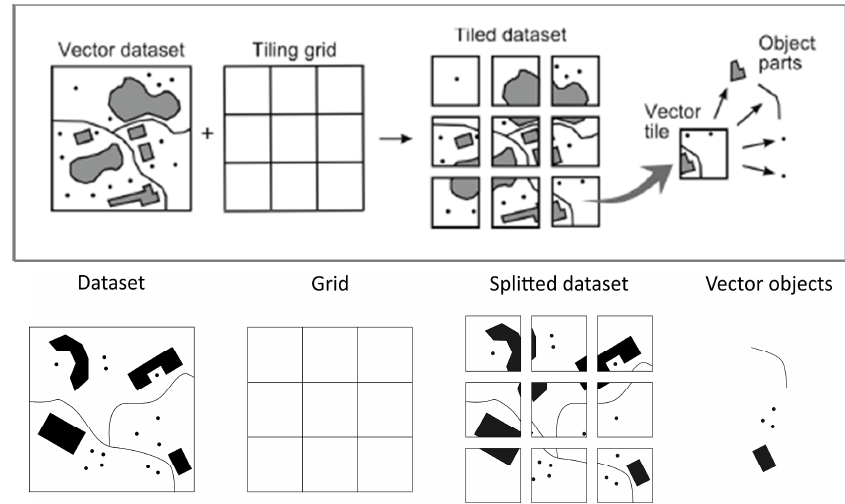
Figure 2. The process of generating vector tiles (according to Gaffuri [23]).